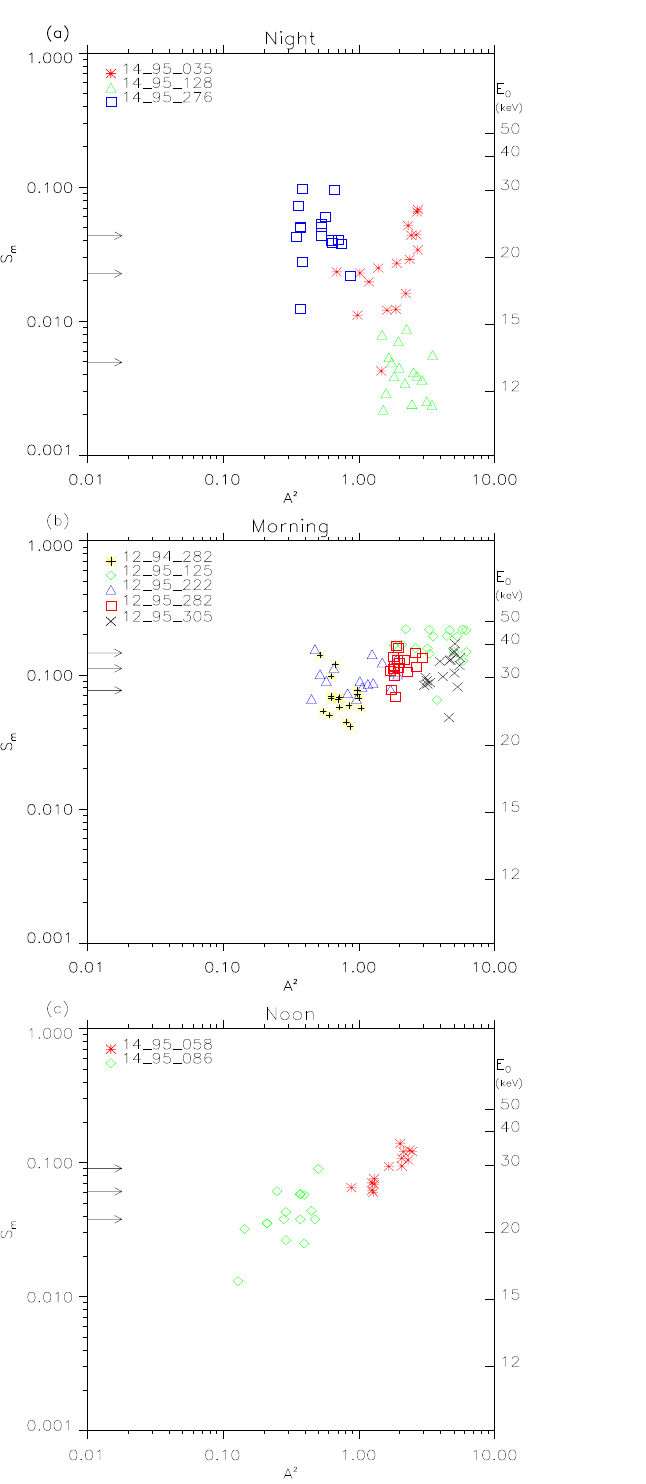
Figure 11: Geometric mean of the spectral indices ( S M = √ S T S P = F M (100) /F M (30)) against A 2 at 2-second =√ × Figure 12: Spectral hardness ratio against A 2 at 2-second intervals for the 10 Kilpisj¨arvi overpasses, divided into S T × S P = Fig. 11. Geometric mean of the spectral indices ( S M intervals for the 10 Kilpisj¨arvi overpasses, divided into night, morning, and noon sectors. (The arrows mark the Fig. 12. Spectral hardness ratio against A 2 at 2-s intervals for the F M ( 100 )/F M ( 30 ) ) against A 2 at 2-s intervals for the 10 Kilpisj¨arvi night, morning, and noon sectors. (The arrows mark the medians and quartiles.) 10 Kilpisj¨arvi overpasses, divided into night, morning, and noon medians and quartiles.) overpasses, divided into night, morning, and noon sectors. (The sectors. (The arrows mark the medians and arrows mark the medians and quartiles.)